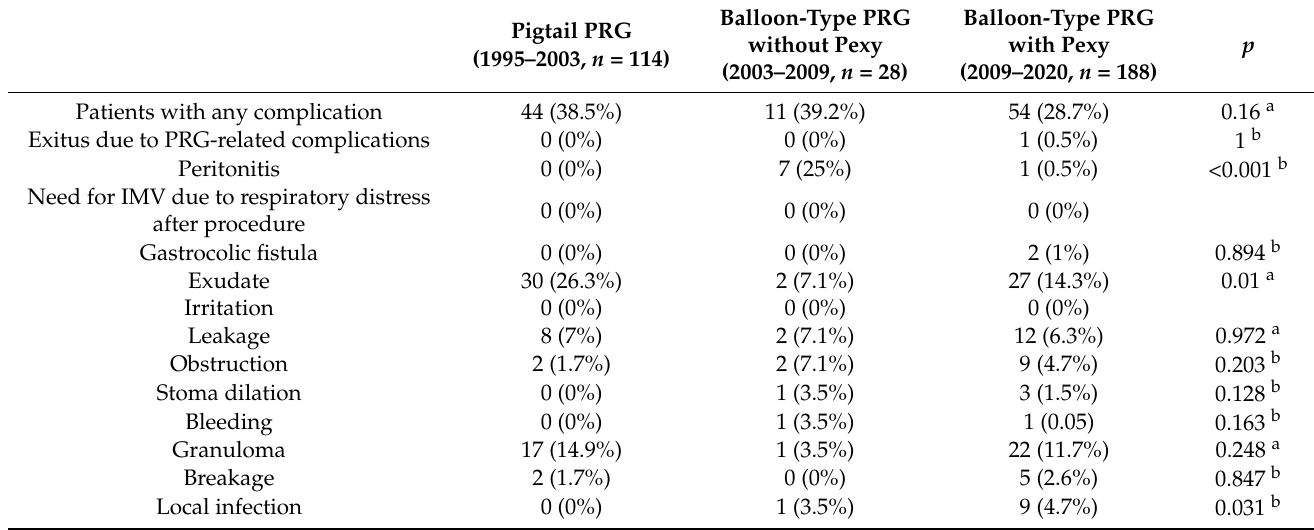
Table 3. Complications associated with PRG in 330 patients treated at the nutrition unit of the Hospital Universitario Virgen del Roc í o between 1995 and